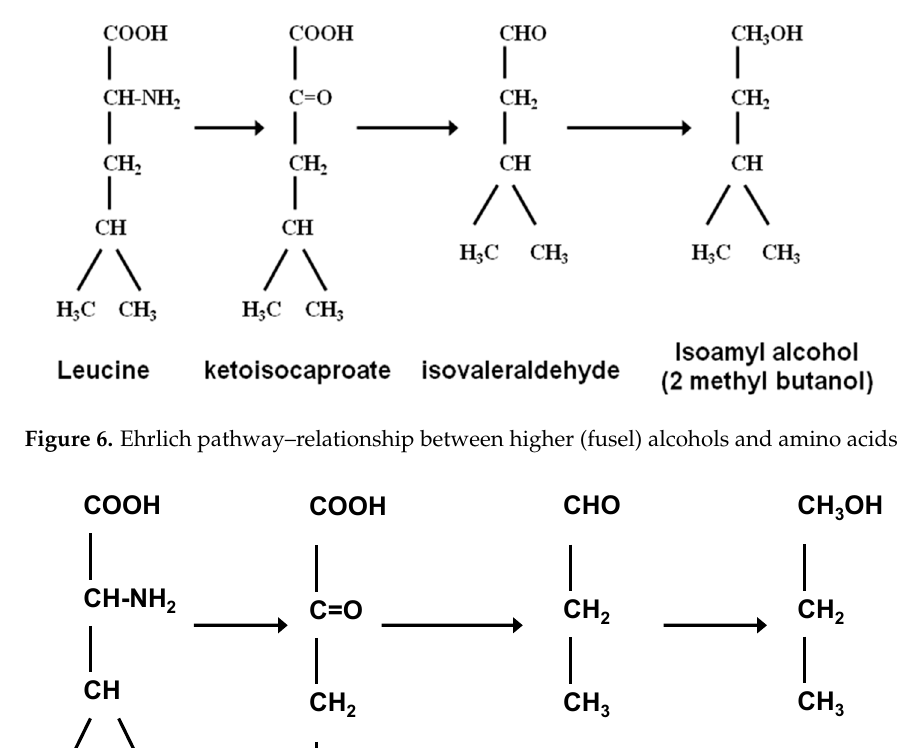
Figure 5. Paul Ehrlich.